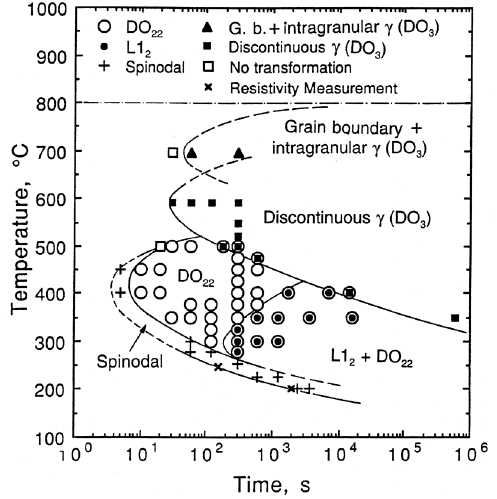
Figure 3. TTT diagram of the alloy Cu–15Ni–8Sn [12] .